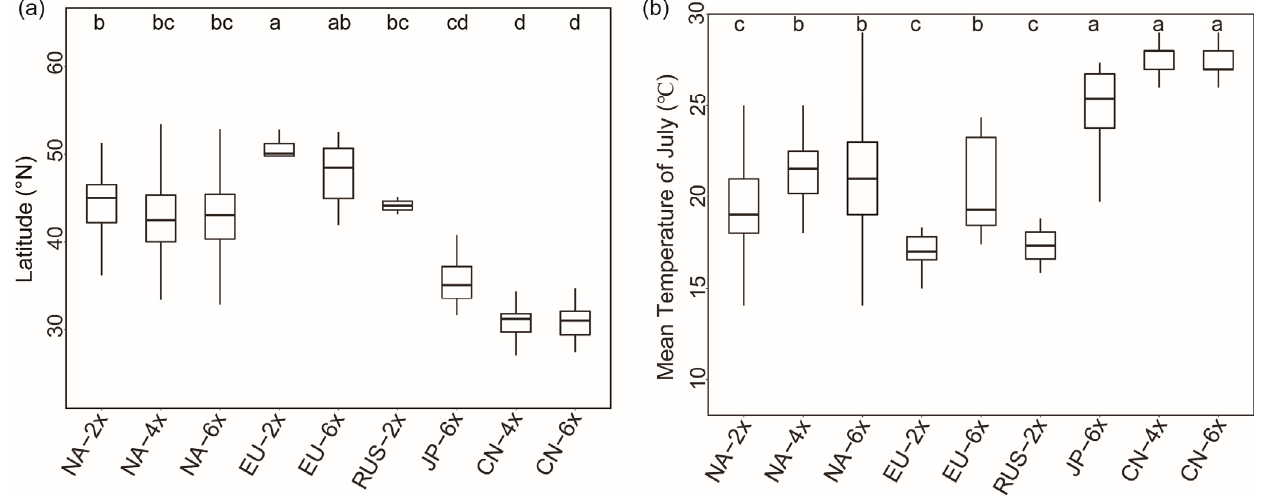
Figure 5. Comparison of latitude ( a ) and mean temperature of July ( b ) of different geo-cytotypes of S. canadensis in different regions. Note: CN represents the population of China, EU represents the population of Europe, JP represents the population of Japan, NA represents the population of North America, and RUS represents the population of Russia. Different lowercase letters indicate significance.